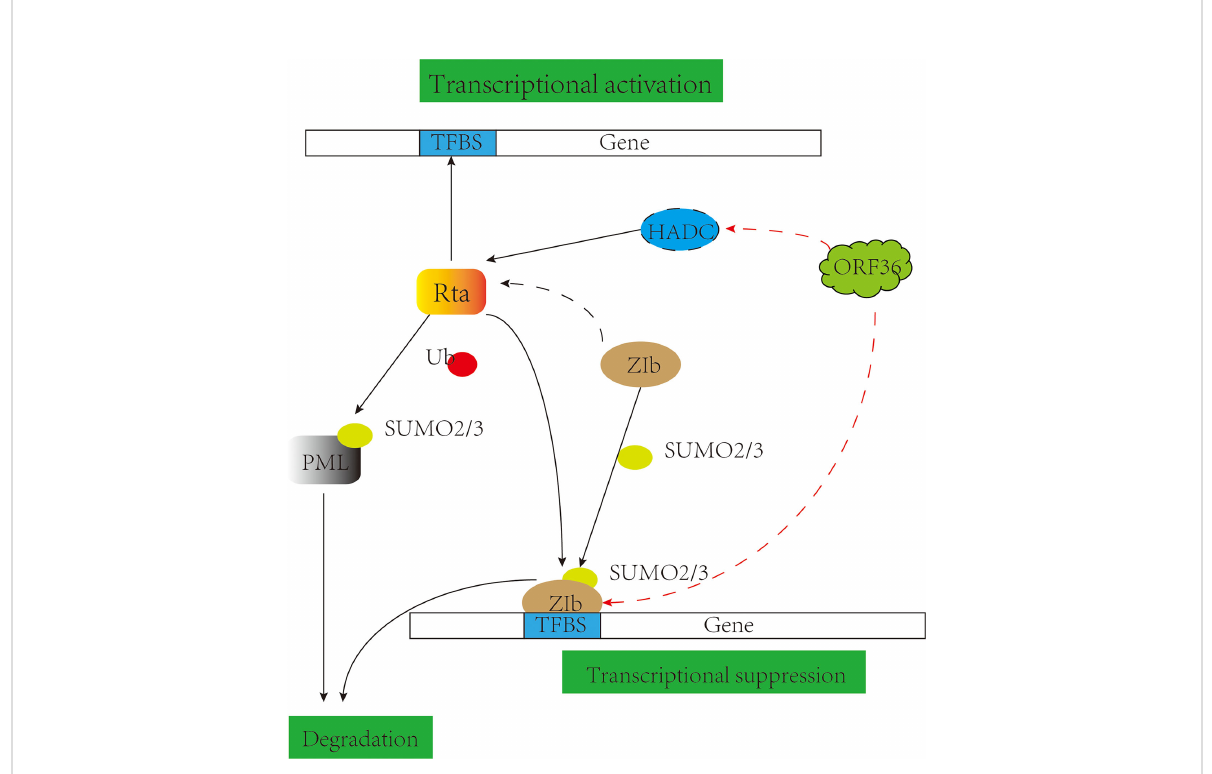
FIGURE 5 pUL13 works with SUMO proteins to promote viral replication. Gammaherpesvirus protein kinase pORF36 interacts with histone deacetylase 1 and 2 (HADC1/2) and prevents the association of these HDACs with the viral promoter driving expression of KSHV replication and transcription activator (K-Rta). pORF36 phosphorylates Thr111 of KSHV basic region-leucine zipper (K-bZIP) and inhibits the SUMO level of K-bZIP to repress the transcriptional inhibition